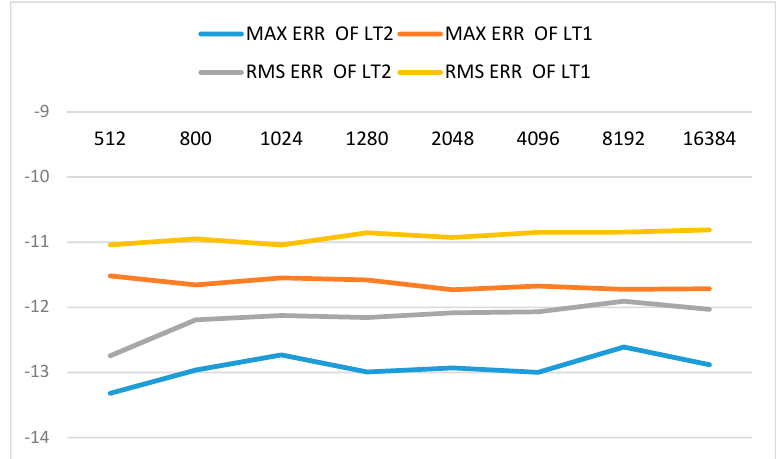
Figure 4. Errors of LT in log10 form with EPS = 1.0E-10 and CMAX = 64 (LT1 is the butterfly algorithm and LT2 is the proposed method. Abbreviations “MAX ERR” and “RMS ERR” denote the maximum error and root-mean-square error, respectively. EPS is desired precision in interpolative decomposition, CMAX is the number of columns in each sub-matrix on level 0).